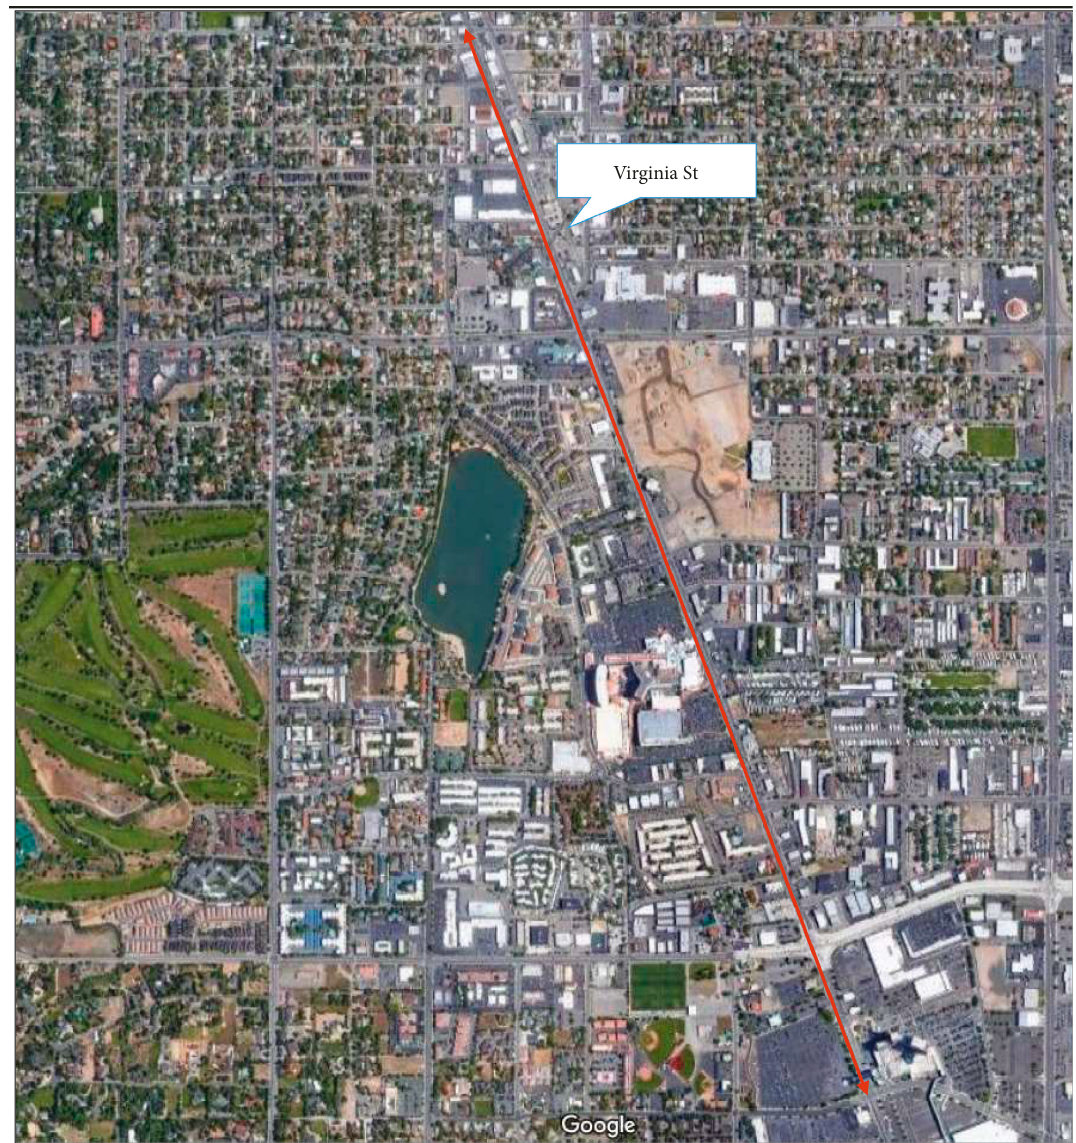
Figure 10: The scope of coordinated segment of Virginia